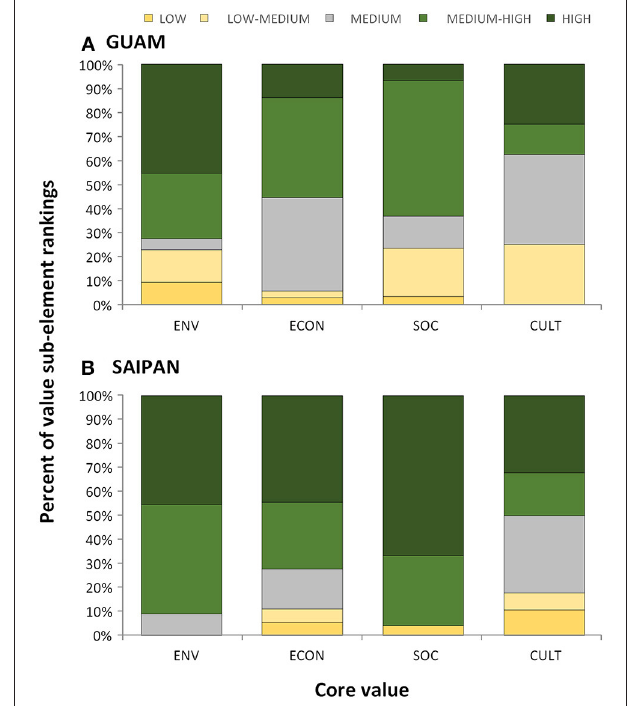
FIGURE 4 | Percentage of each core value subcomponent that was rated as having a high, moderate or low value by survey respondents for: (A) Guam; and (B) Saipan. Where values are denoted as ENV, environmental; ECON, economic; SOC, social; and CULT,